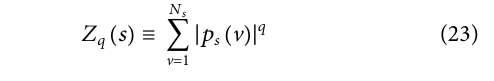
Frontiers in Physiology |